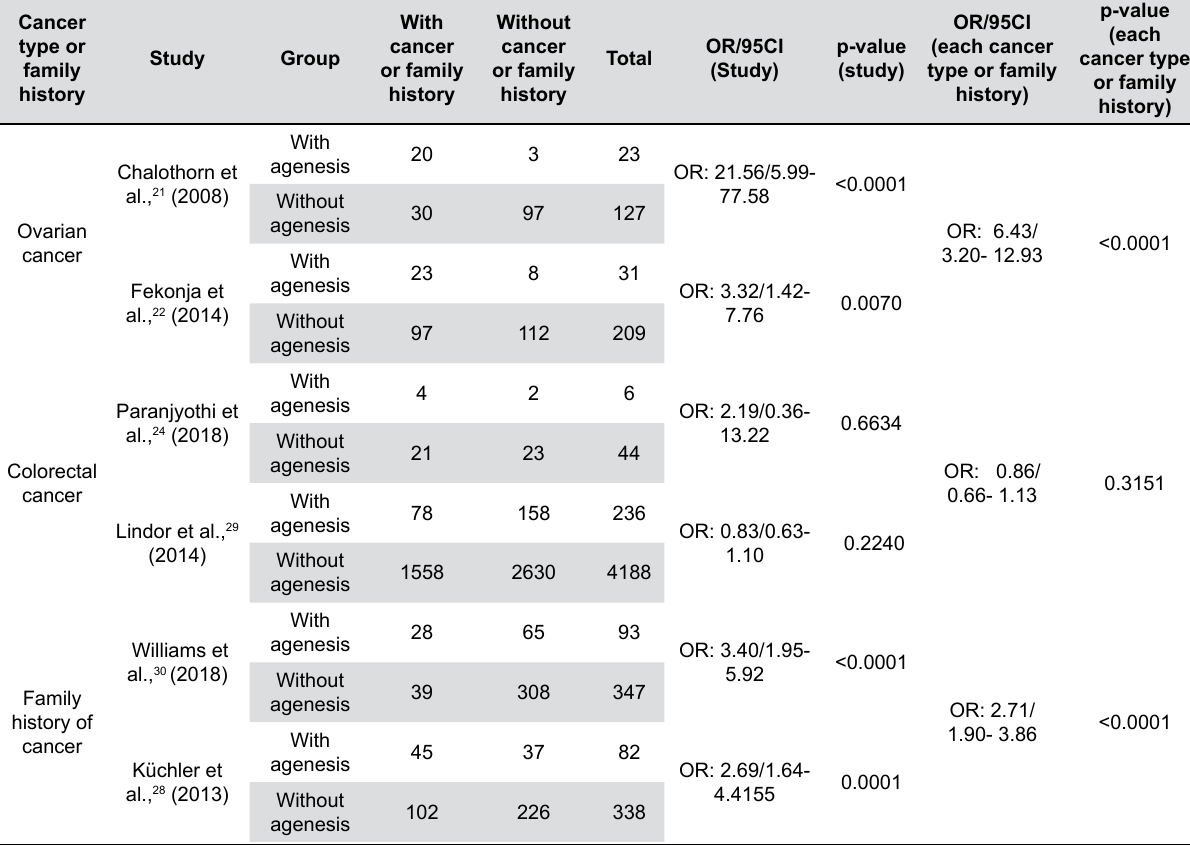
Table 2- Odds ratio of the included studies